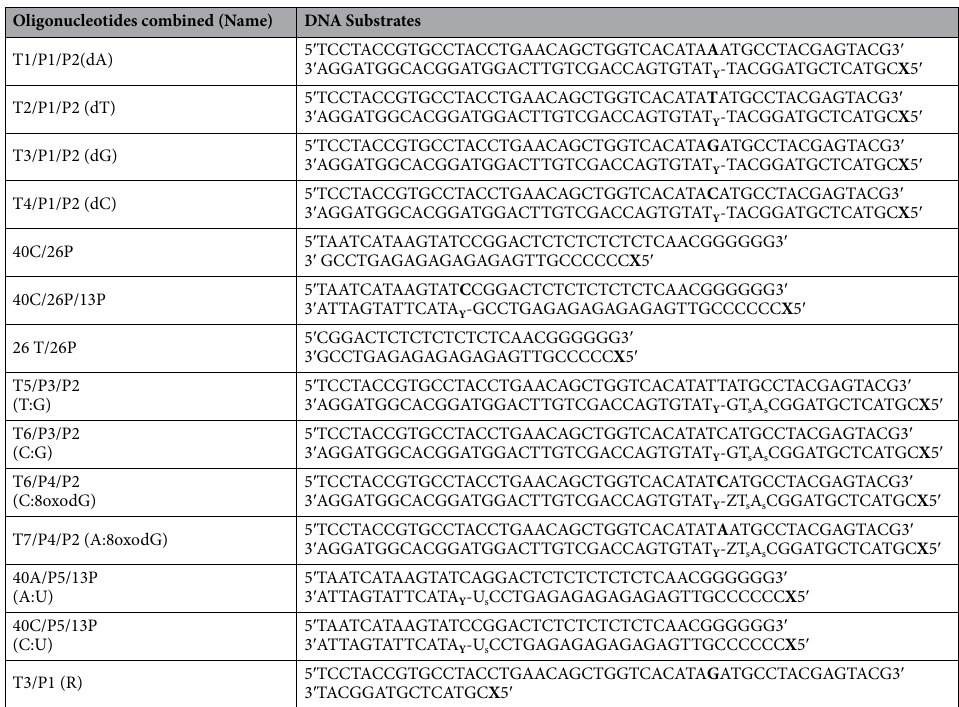
Oligonucleotides combined (Name) DNA